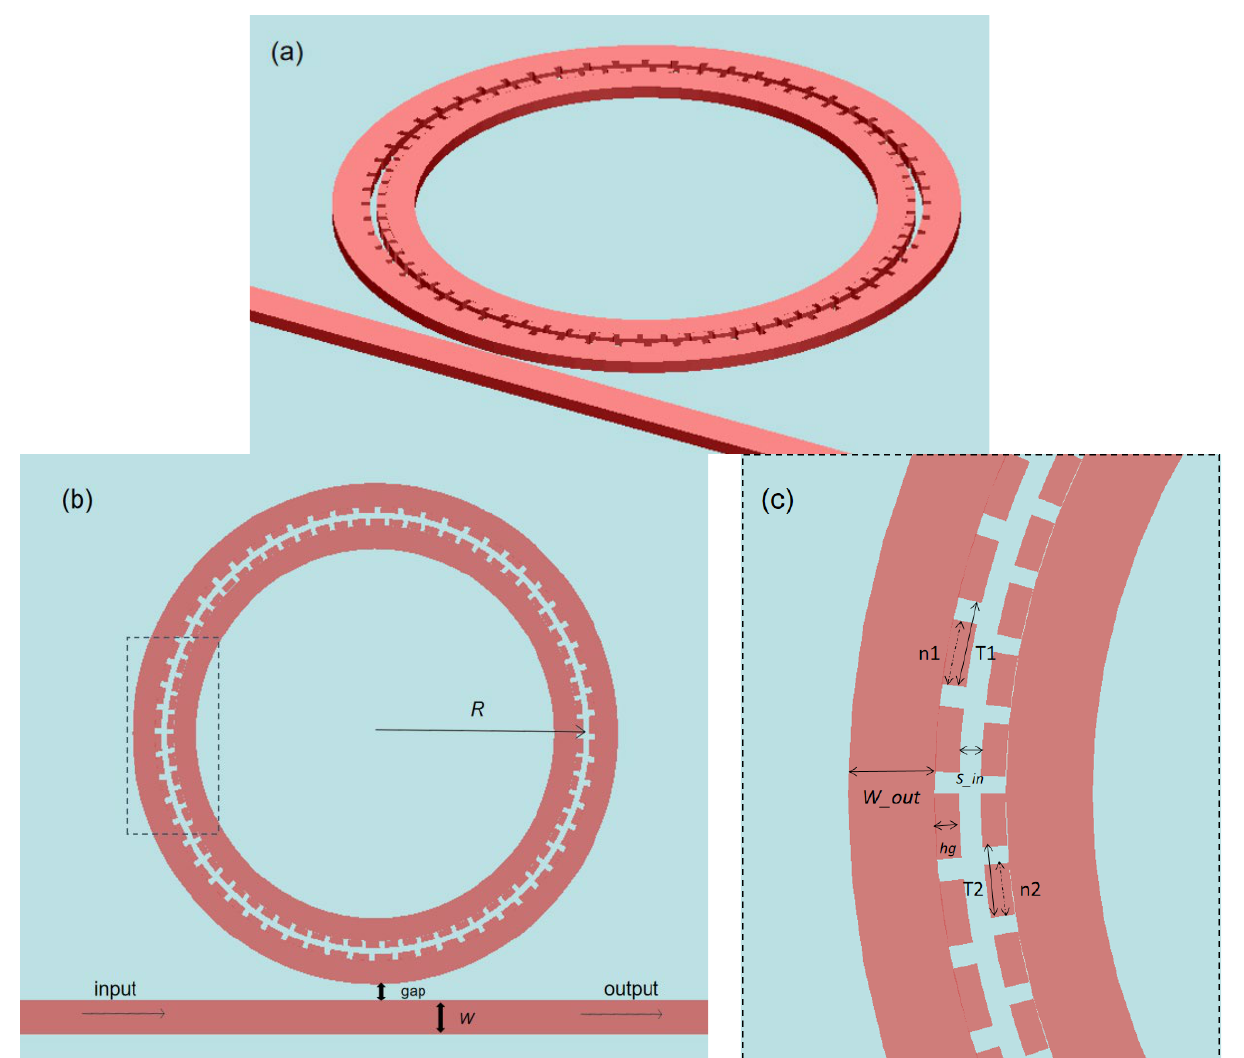
Figure 1. Structure diagram of ASGMRR. ( a ) Three-dimensional structure; ( b ) Top view; ( c ) Slot enlarged view.